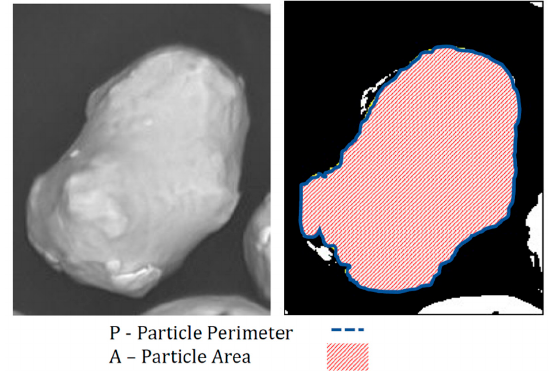
Figure 3. Powder Particle Circularity calculation description.